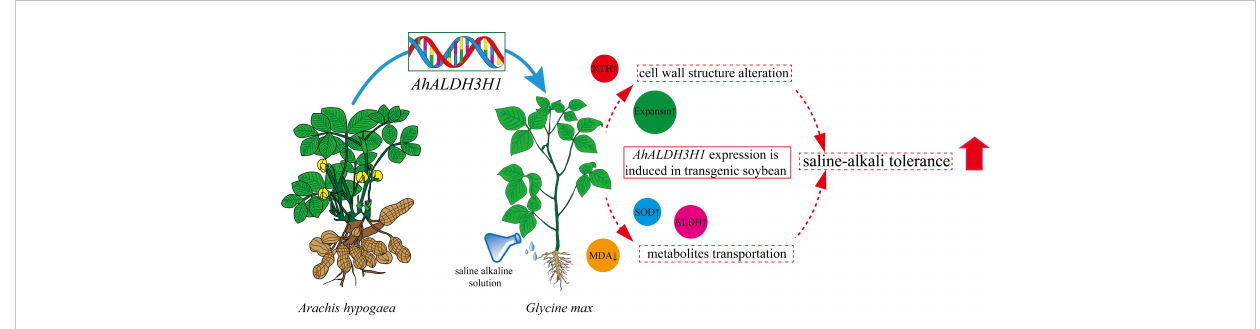
FIGURE 7 Saline-alkali tolerance regulatory network of AhALDH3H1 transgenic soybean. The changes of AhALDH3H1 introduction in soybean under saline- alkali stress were represented as circles which shaded with different